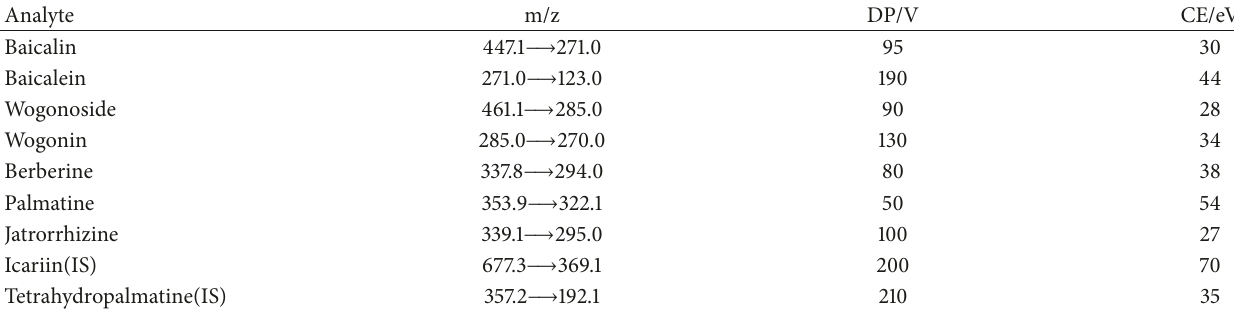
Table 1: Optimized precursor/production pairs and multiple reaction monitoring (MRM) parameters for the analytes and